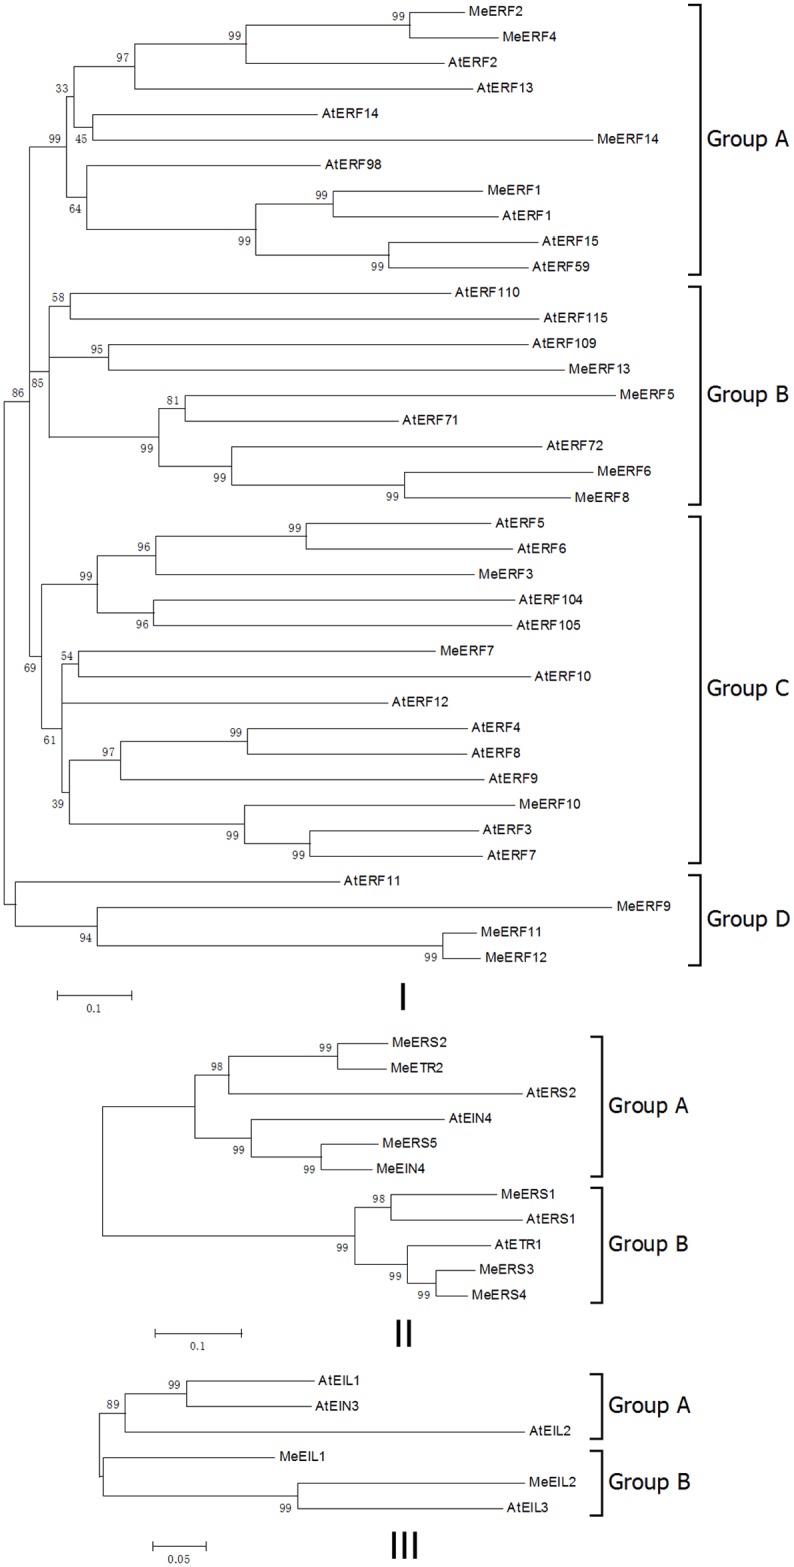
Phylogenetic trees of ethylene receptors and transcription factors in cassava (Manihot esculenta, Me) and Arabidopsis (Arabidopsis thaliana, At).The phylogenetic trees were generated using MEGA5.0 program with the neighbor-joining method. Bootstrap values from 1000 replicates are indicated at each branch. I, phylogenetic tree of ERFs that clustered into four distinct groups (A, B, C, and D groups); II, phylogenetic tree of ethylene receptors that clustered into two distinct groups (A and B groups); III, phylogenetic tree of EILs that clustered into two distinct groups (A and B groups).